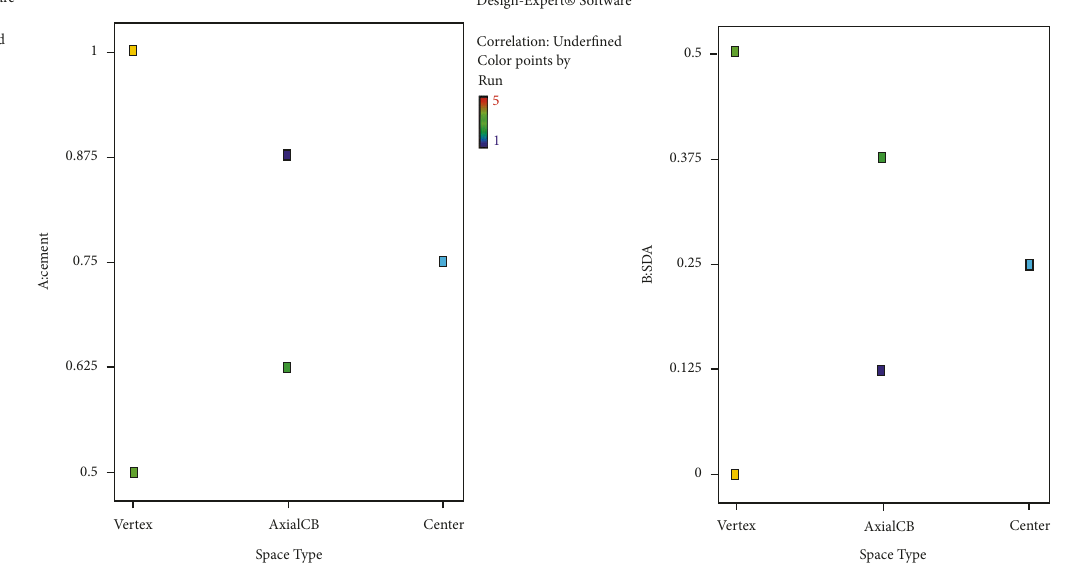
Figure 2: Two-component factor space.